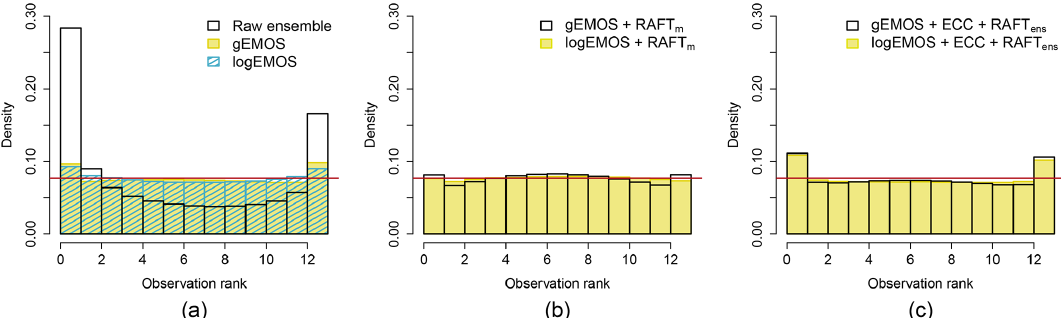
Figure 5. Verification rank histograms for different forecasting methods, aggregated over all sites, model runs and lead times. RAFT his- tograms are based on the final adjustment for each lead time.